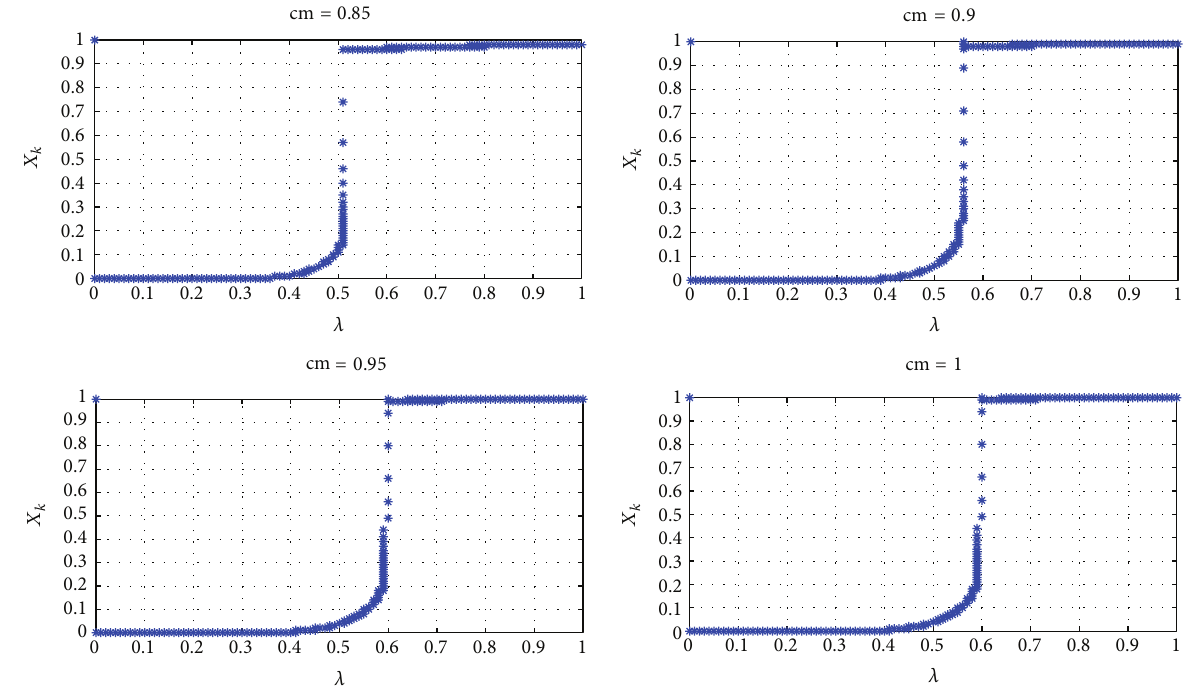
Figure 14: Bifurcation diagram using cm = 0.85, 0.90, 0.95, and